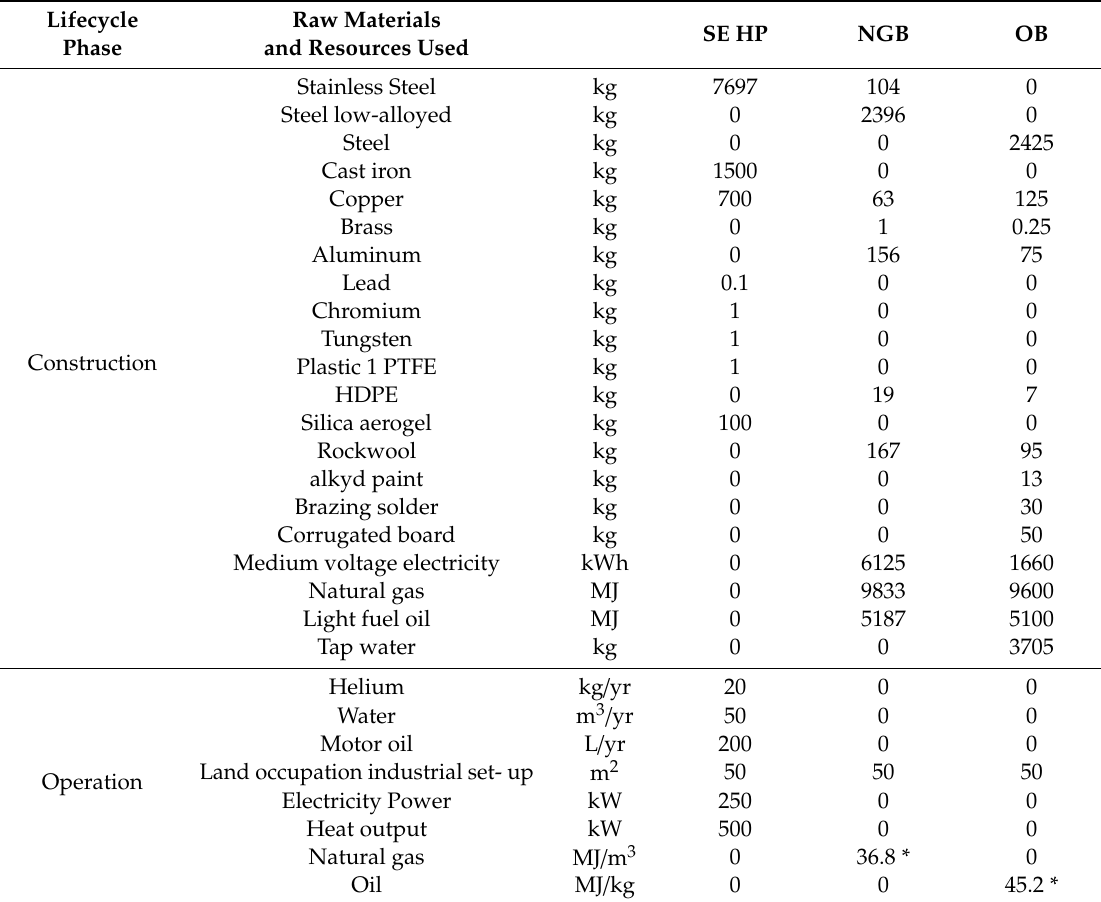
Table 1. Inventory data for LCA analysis of Stirling engine-based HP, Natural gas-fired boiler and oil